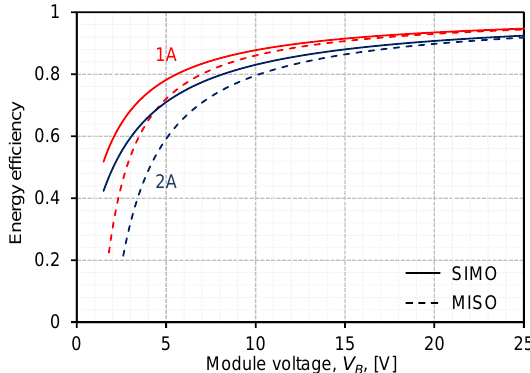
Figure 5. Efficiency of the SC converter model at different currents and voltages.